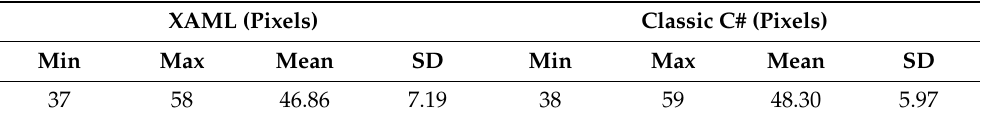
Table 4. The descriptive statistic of the average pupil diameter is based on XAML and classic C# ( n = 36). XAML (Pixels)